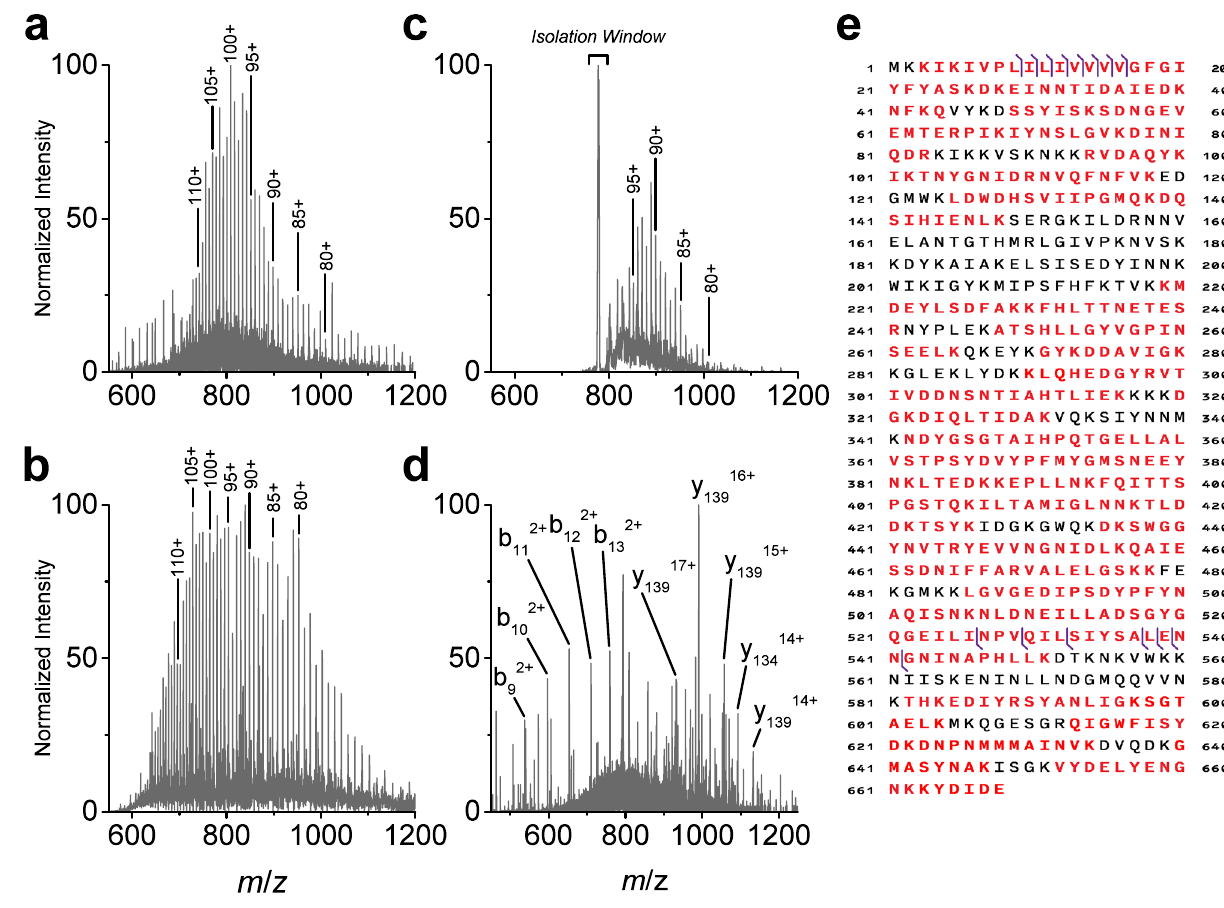
Figure 1. Identification of PBP2a mecA protein from MRSA cell extract by LC–MS/MS. ( a ) Intact wild-type PBP2a mecA MS spectrum from a representative MRSA strain (ATCC 33,591) separated by LC. Intact protein precursor ion charge states are labelled from 80 to 110. Data are representative for multiple MRSA strains (n ≥ 3). ( b ) Recombinant His 6 -PBP2a mecA MS spectrum acquired using direct infusion. Identical precursor ion charges states are labelled as wild-type PBP2a mecA spectrum. ( c ) Intact wild-type PBP2a mecA MS spectrum produced during LC separation of cell extract and PTCR-mediated separation of superposed protein ion populations. Isolation window was centered at m / z 777 with a width of 5 m / z . Precursor ion charge states are labelled from 80 to 95. Data are representative of multiple technical replicates from the same MRSA cell extract (ATCC 33,591). ( d ) MS/MS spectrum of intact wild-type PBP2a mecA precursor ion at m / z 793 (charge state = 102), using 1.5 m / z isolation window and fragmented with an HCD collision energy of 10 eV. Abundant N-terminal ( b -ions) and C-terminal ( y -ions) fragment ions are labelled. Fragmentation data are representative for multiple charge states and different MRSA strains (n ≥ 100). ( e ) Associated b- and y-ion fragment location for MS/MS of intact wild-type PBP2a mecA protein indicated by purple vertical lines. Red colored amino acids indicate protein coverage (72.2%) for complementary bottom-up peptide analysis and protein characterization. Protein coverage associated with peptide data are from multiple analyses (n =